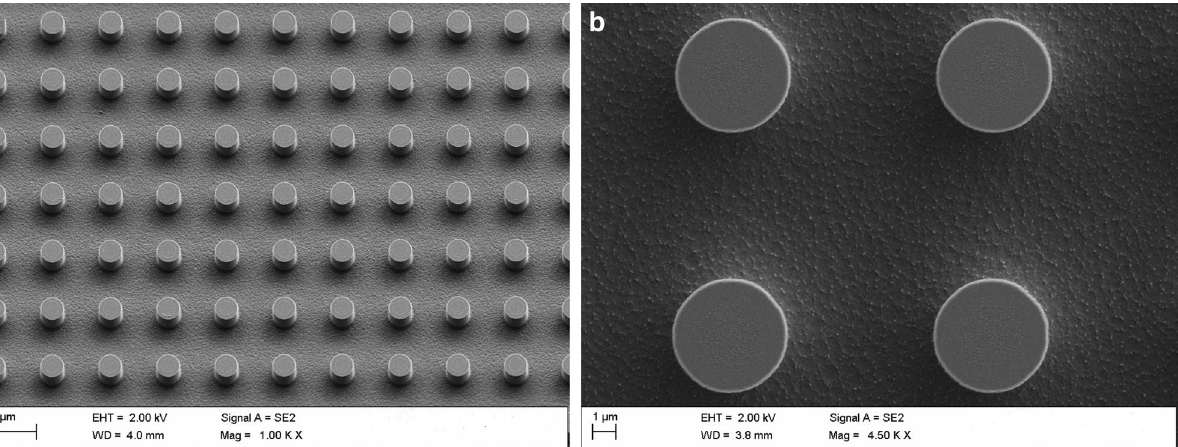
Figure 1. Topography of the structured films: 5 μm diameter micropillars fabricated on a PP substrate (left; 10 µm scale), where the roughness they show at the bottom corresponded to the presence of nanospikes (right; 1 µm